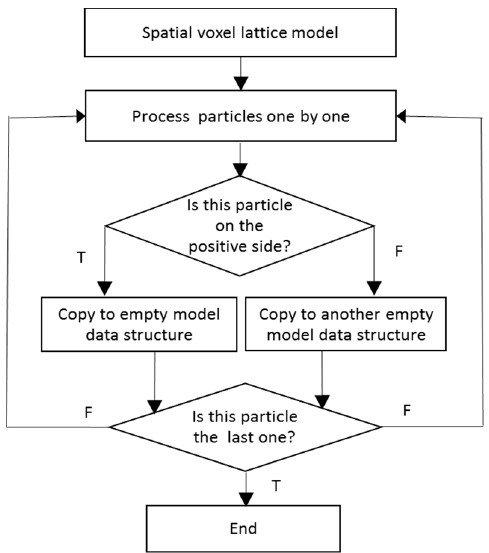
Figure 16. Steps to separate particles into different groups. ISPRS Int. J. Geo-Inf. 2017 , 6 , 77